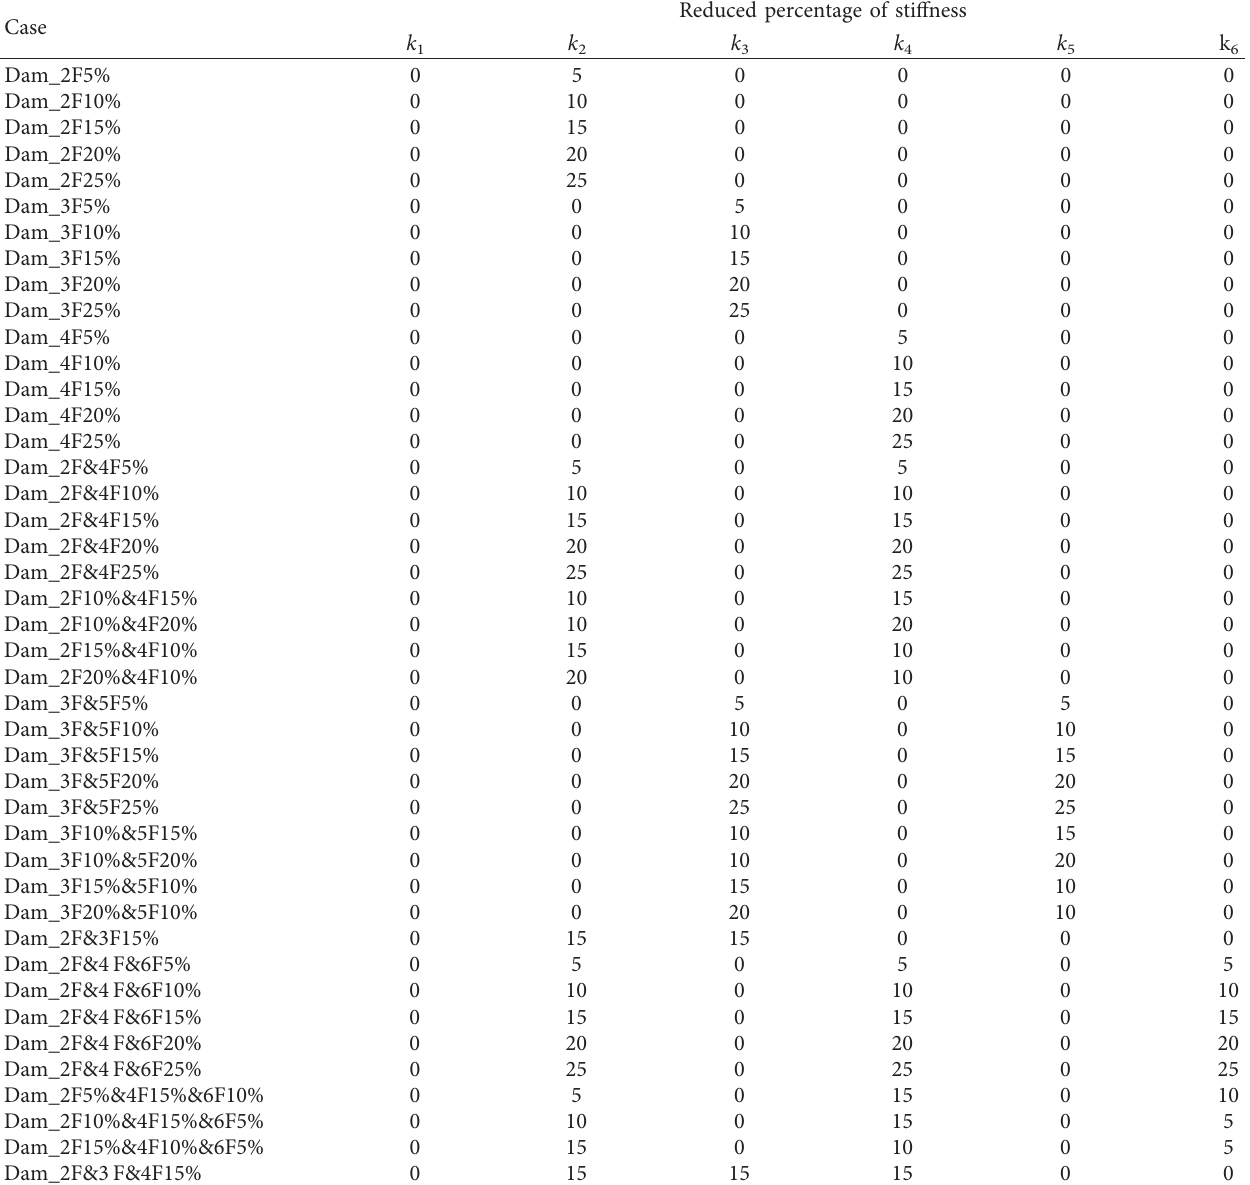
Table 1: Damage scenarios of the numerical